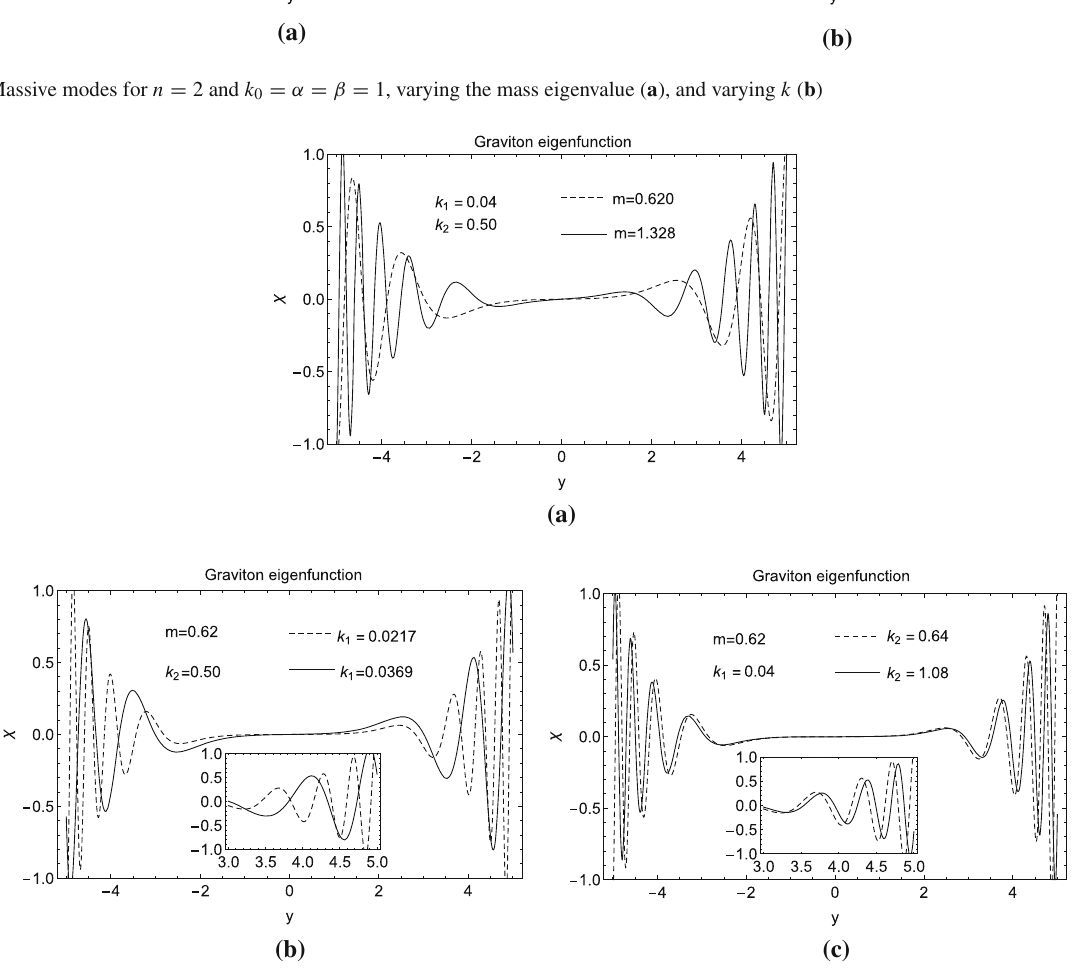
Fig. 9 Massive modes with α = β = 1, varying the mass eigenvalue ( a ), varying k 1 ( b ), and varying k 2 ( c )